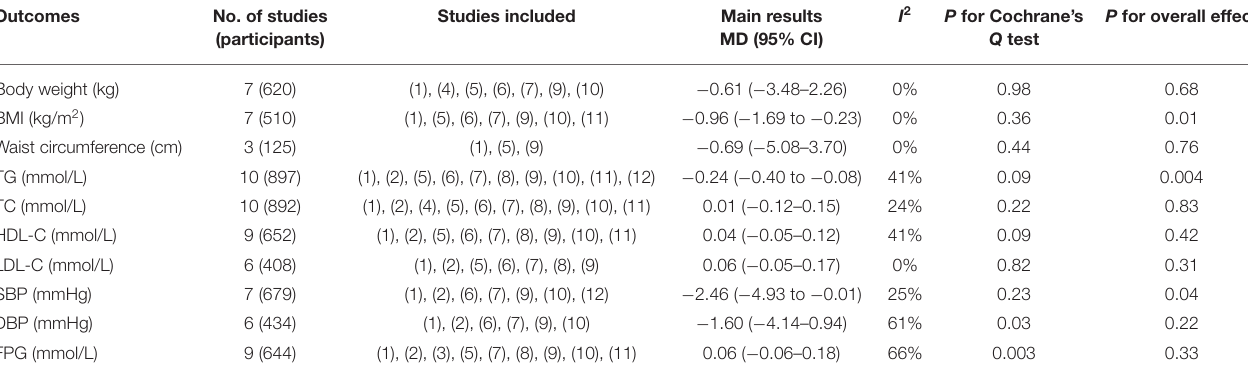
TABLE 3 | Summaries of main findings of the